Question: Describe this figure in one sentence.
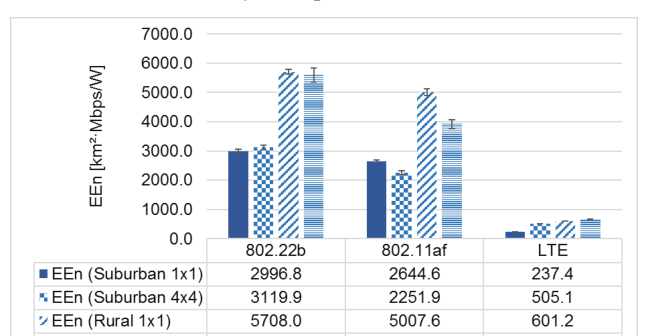
Answer: shows the average network energy efficiency for  MIMO 4x4 compared with SISO configuration. In the  suburban scenario, the energy efficiency of IEEE 802.22b  with a 4x4 MIMO configuration is slightly increased by 4%  while for LTE by 47% (compared with SISO). For  IEEE 802.11af the energy efficiency decreases approximately  15% when comparing with SISO. In the suburban scenario,  four transmitting antennas significantly increases the network  energy efficiency for LTE but not for TVWS. For LTE BSs,  the transmitters consume less than 10% of the BS total  consumed power. The coverage increase realized by the  MIMO diversity gain, together with the reduction of BS sites,  overcompensates the increase in the transmitters’ power  consumption. For TVWS BS the power consumption of the  transmitters represents around 40% of the total consumed  power. The increase in the power consumption of the  transmitters is not always compensated.